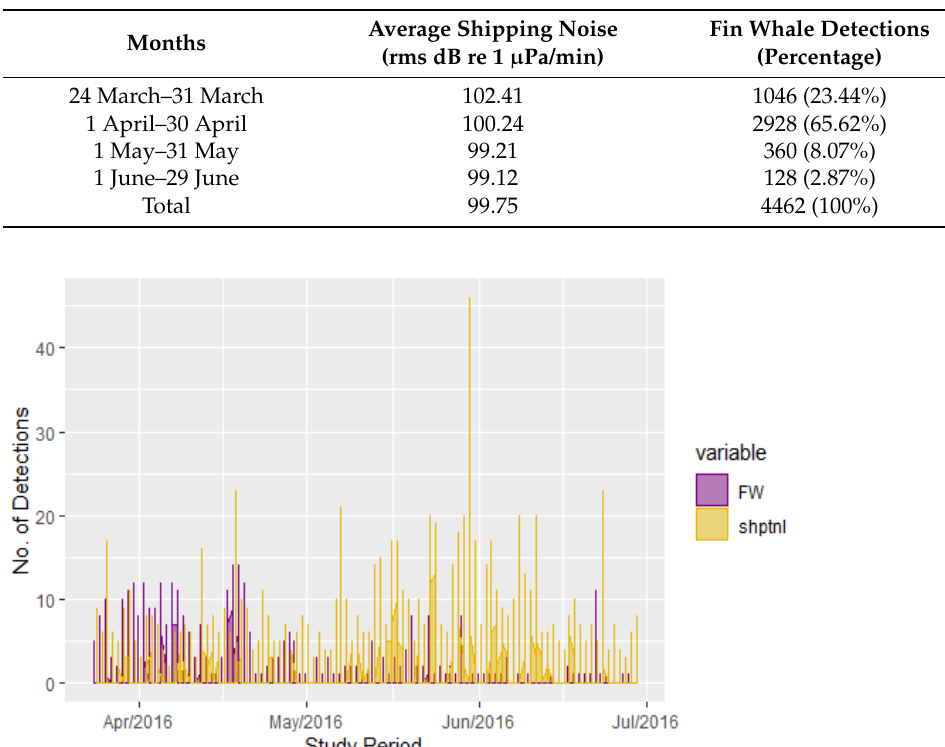
Table 4. Results of the logistic regression with significant explanatory variables for fin whale de- tections. Covariates Odds Ratio Std. Error Shipping noise levels (rms) *